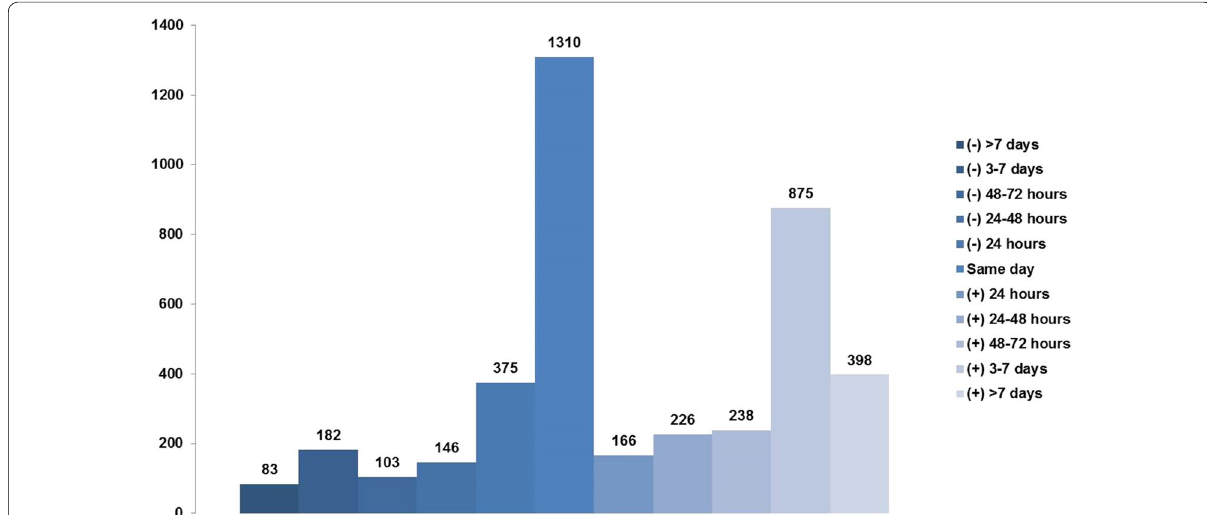
Fig. 2 Timing of NIV with relation to IMV ( N 3866). Negative values denote NIV use before IMV and positive values denote NIV use after IMV. IMV = invasive mechanical ventilation, NIV noninvasive ventilation